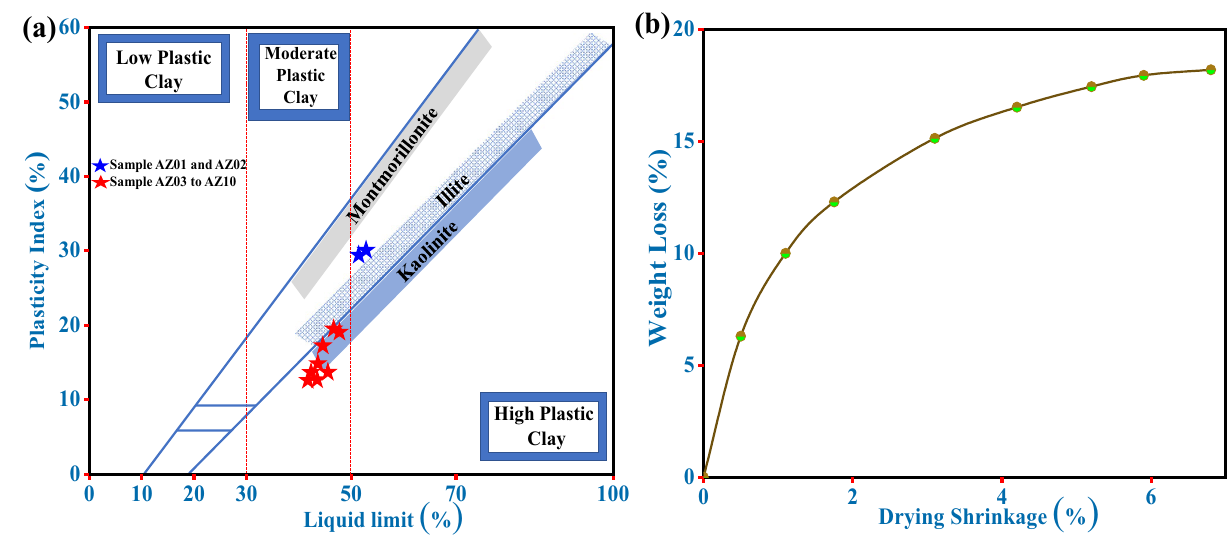
Figure 6. Shows: ( a ) The position of studied clay samples on the Holtz and Kovacs diagram (after Holtz and Kovacs (1981) 74 ) and ( b ) Bigot curves of the clay